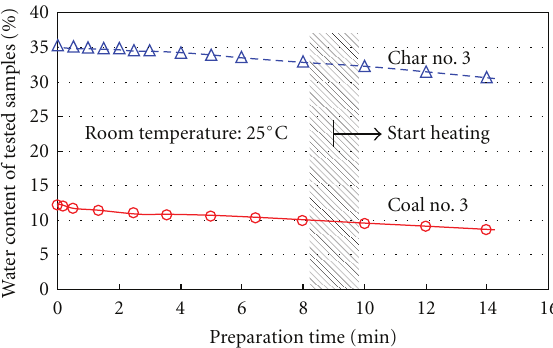
Figure 4: Water loss by evaporation from Coal no. 3 and Char no. 3 for preparation